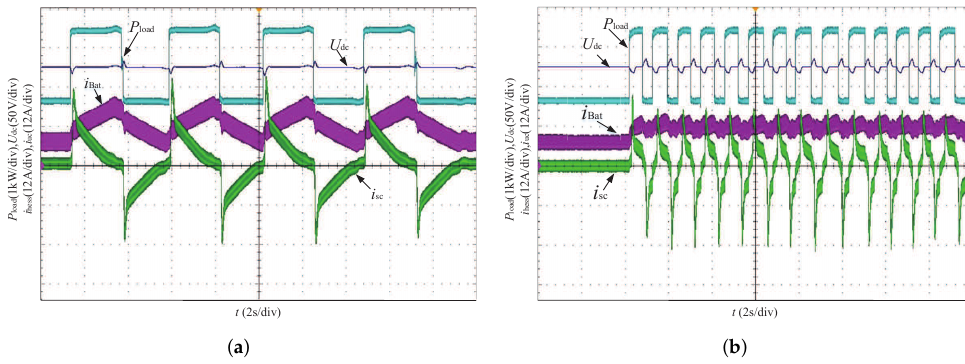
Figure 9. Experimental comparison of at different sampling time, ( a ) t = 2 s, t 0 = 4 s; ( b ) t = 1.8 s, t 0 = 1.8 s.